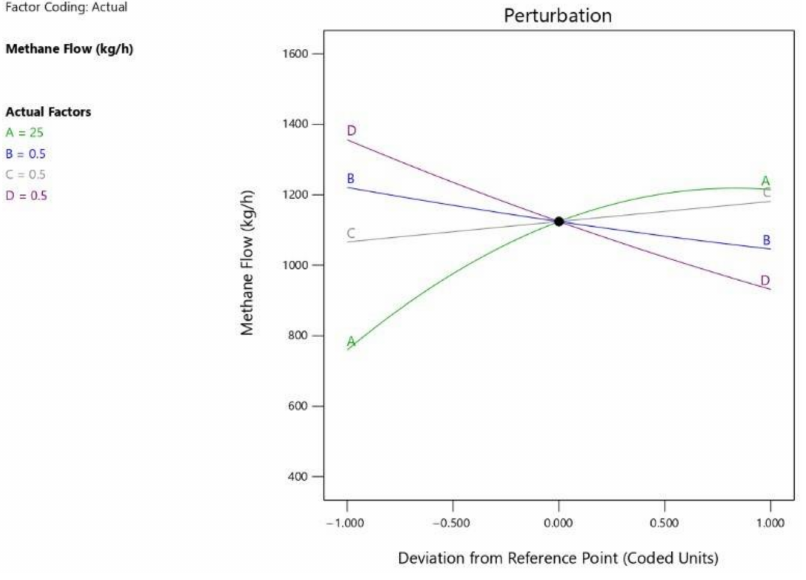
Figure 2. Perturbation plot of methane flow